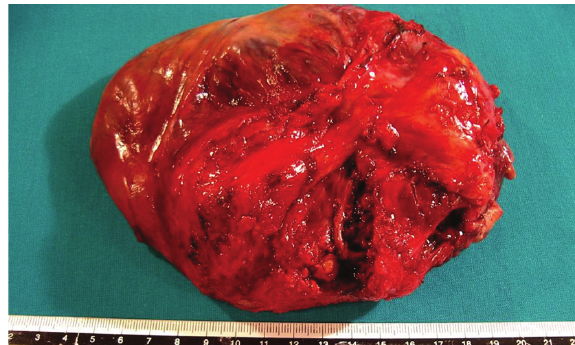
Figure 2: Giant ovarian tumour with capsular disruption and strong red surface colour due to